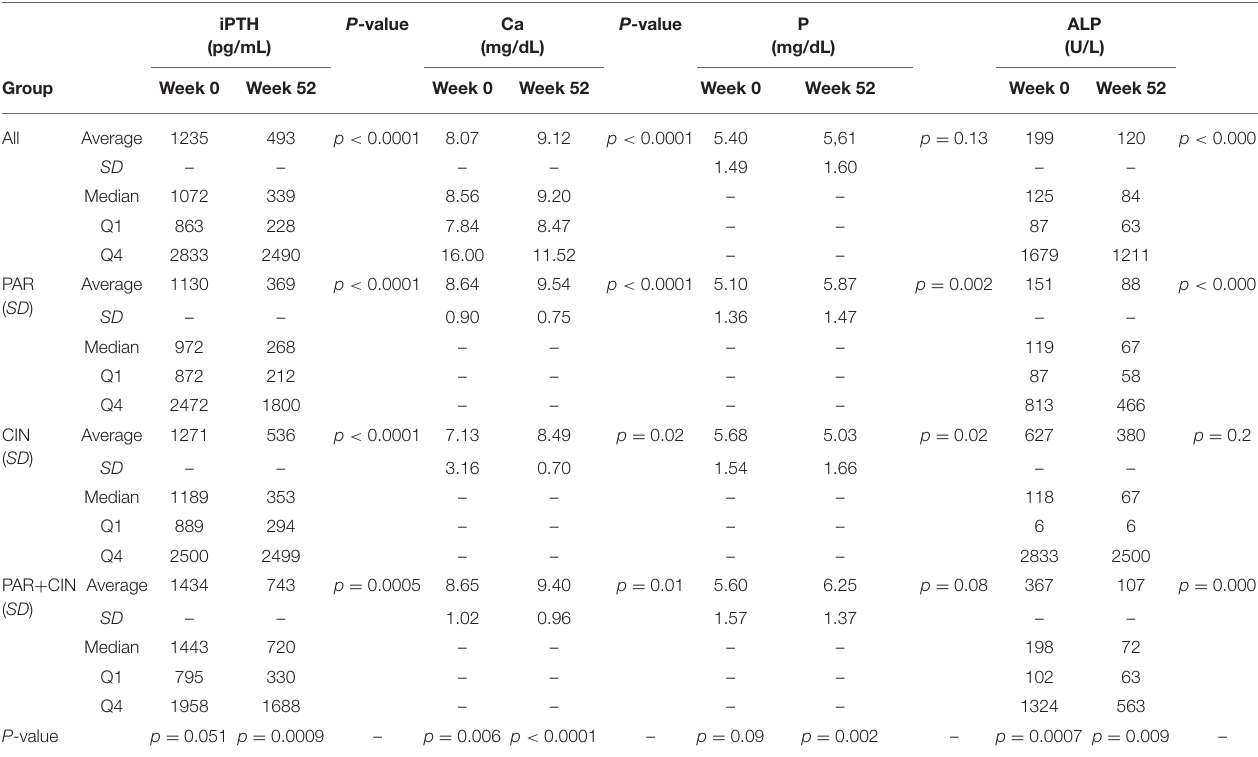
TABLE 2 | The effect of treatment on serum PTH, calcium, phosphate, and alkaline phosphatase.